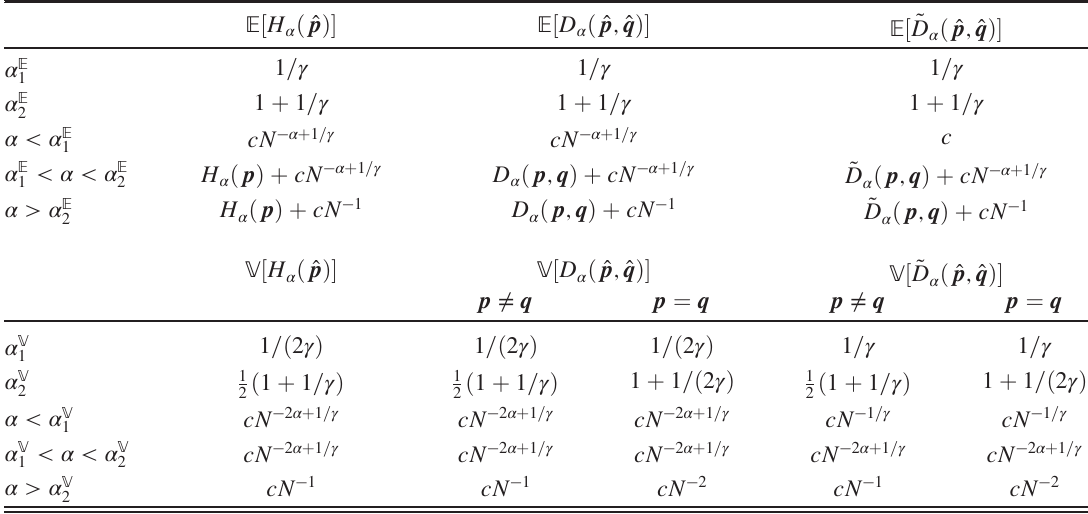
TABLE II. Summary of finite-size scaling for distributions with heavy tails. Mean ( E ) and variance ( V ) of the ~ D ˆ p and ˆ q each of size N drawn randomly from p and q with power- plug-in estimator of H α , D α , and α for samples law rank-frequency distributions with exponent γ > 1 , Eq. (1). The results are obtained by combining Table I with Eq. (14) (for details see Appendixes B and C). The constant c depends on α and has a different value in each case but is independent of N . The limit γ → ∞ corresponds to the case in which both p and q have short tails. ˆ p Þ(cid:3) E ½ D ˆ p ; ˆ q E ½ H α ð α ð